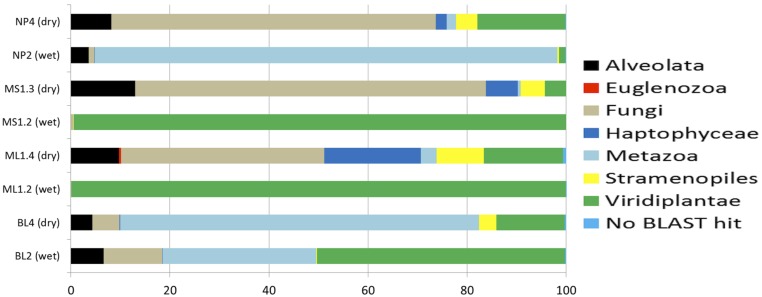
Percentage composition of eukaryotic communities as based 18S rRNA-based amplicon pyrosequencing. The total number of sequences for each sample: NP4, 2556; NP2, 9623; MS1-3, 1058; MS1-2, 9060; ML1-4, 2958; ML1-2, 14642; BL4, 5417; BL2, 2101.